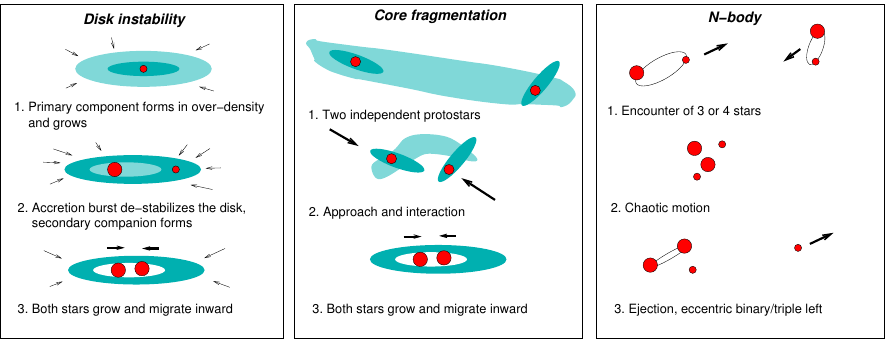
Figure 7. The two major channels of binary-star formation are disk instability and core fragmentation. Dynamical interactions in N-body systems also can leave a strong imprint on the binary